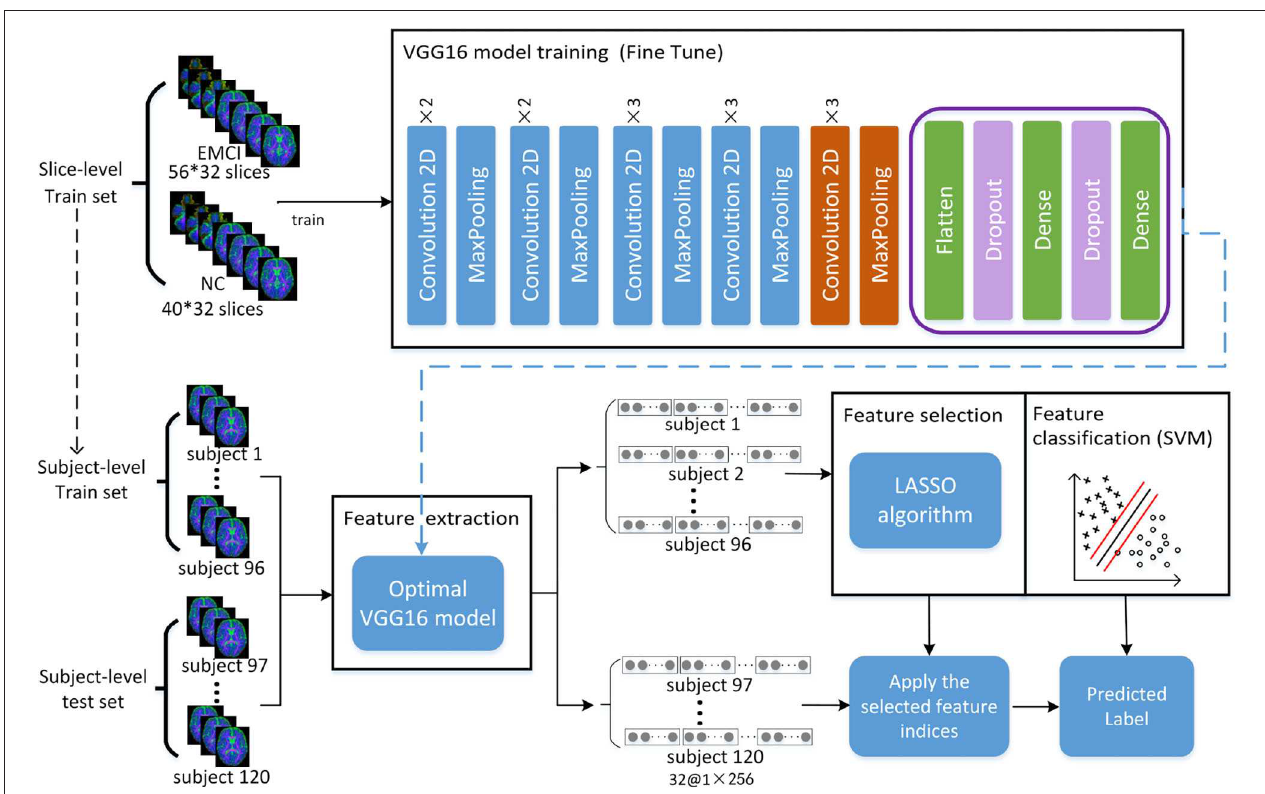
FIGURE 2 | Total framework of proposed method, where the VGG16 model consists of five convolution blocks and a fully connected layer. For one slice, the output of VGG16 model is a matrix of 1 × 256. For each subject with 32 slices, 32 feature matrixes of 1 × 256 are acquired from VGG16, and they are then concatenated as a feature representation with the dimension of 1 × 8192. A total of 120 feature representations of 120 subjects are finally obtained, where 96 subjects used for training VGG16 network make up training set for feature selection and classification and 24 subjects make up test set for